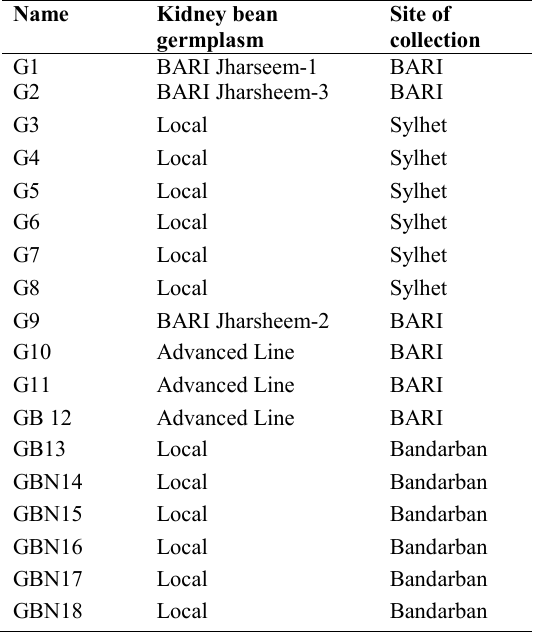
Table 1. List of Kidney bean germplasm collected